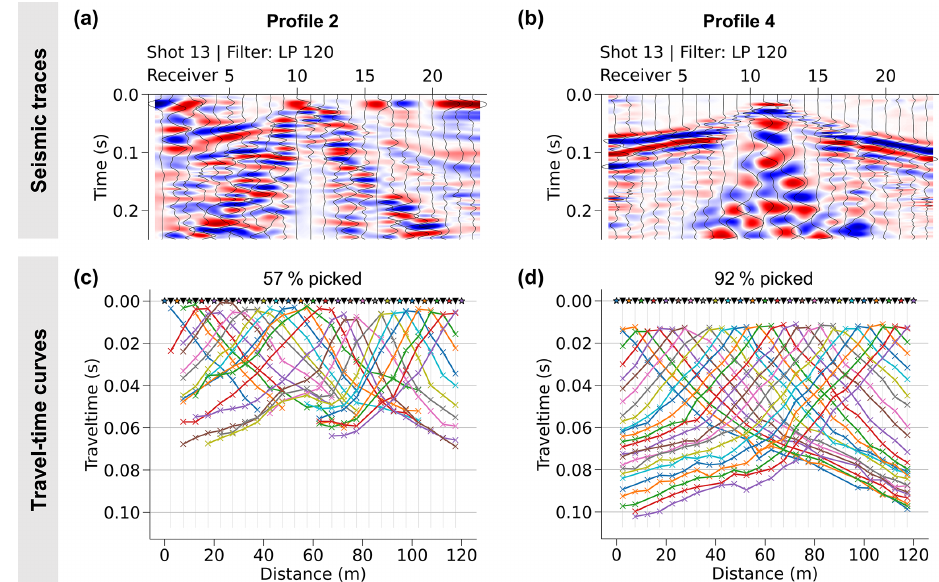
Figure A3. Exemplary seismic traces (wiggle traces with variable density plots in the background) corresponding (a) to Profile 2 with a high noise level and (b) to Profile 4 with a much lower noise level. As a direct result of data quality, the travel-time curves (c) of Profile 2 (picking percentage 57%) are much less populated than those (d) of Profile 4 (92%). The loss of information particularly affects late travel times and thus significantly reduces the depth of investigation along noisy